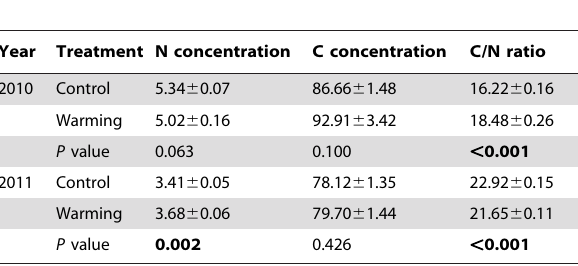
Figure 5. Warming effects on the responses of the maximum rate of Rubisco carboxylation ( V cmax ), the maximum rate of photosynthetic electron transport ( J max ) and the J max / V cmax ratio to foliar temperature ( T leaf ) in 2010 (left panels) and 2011 (right panels). The filled circles indicate the warming plots and the open circles for the control plots. (A) and (B) area-based V cmax ; (C) and (D) area-based J max ; (E) and (F) N-based V cmax ; (G) and (H) N-based J max ; (I) and (J) the J max / V cmax ratio. Each data point is the average of 4 replicates.